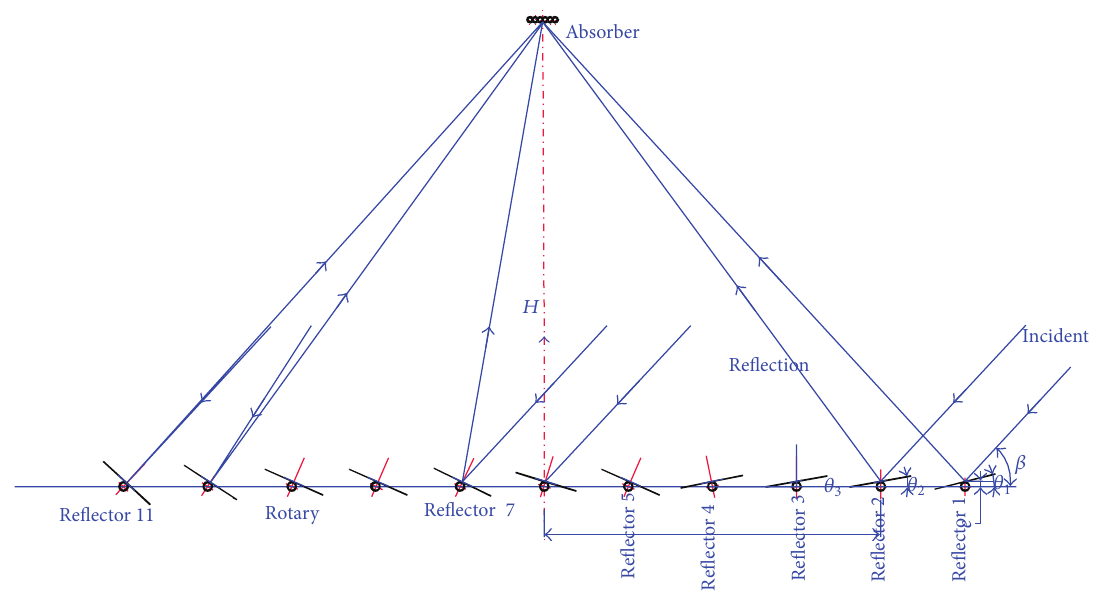
Figure 1: Diagram of the Fresnel solar reflection technology.